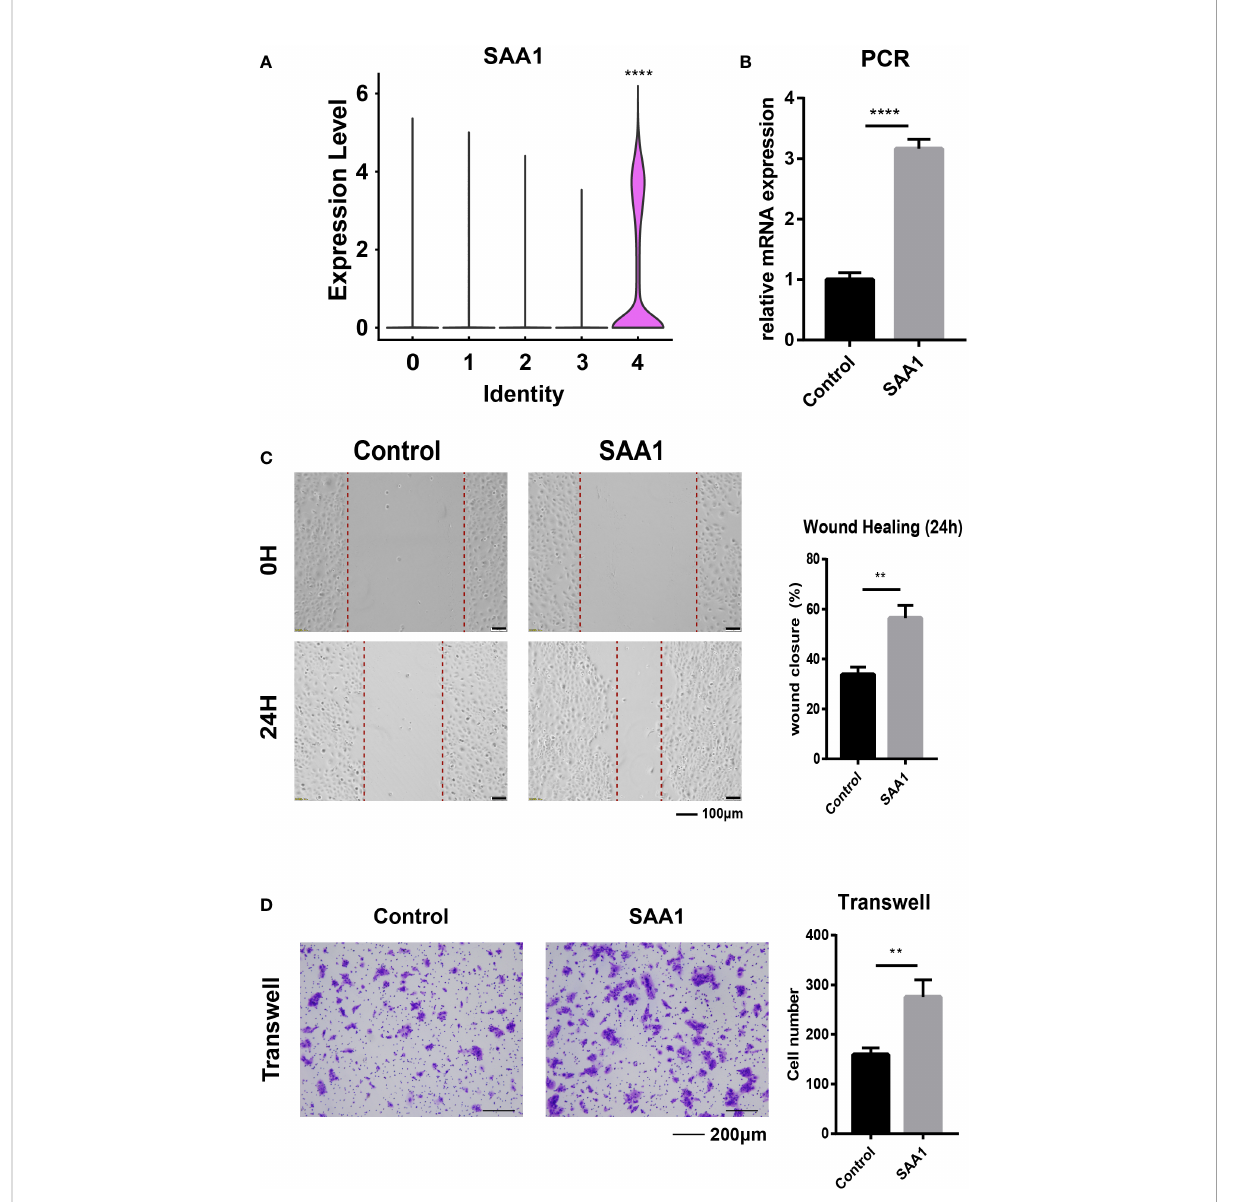
FIGURE 3 SAA1 is the primary target for EC-4. (A) . Violin plot showing the expression of SAA1 in different epithelial subpopulations. (B) . PCR analysis con fi rmed the overexpression of SAA1. (C) . Wound healing assays were performed to evaluate the migratory capacity after overexpression of SAA1. (D) . Transwell assays were performed to assess the invasion capacity after overexpression of SAA1. The symbols ** and **** represent p- values less than 0.01 and